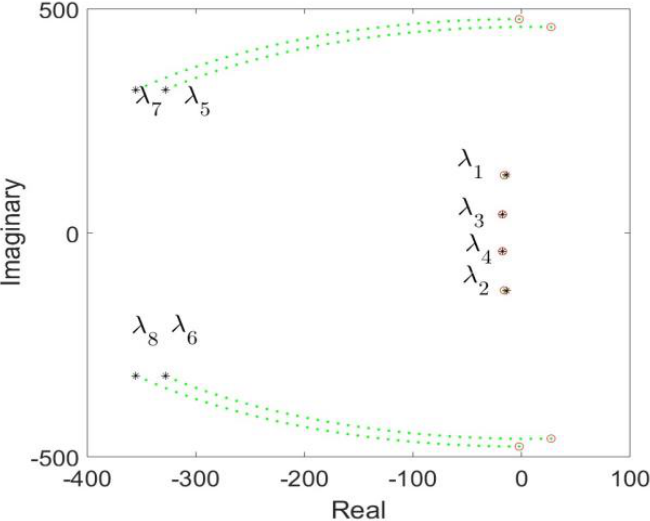
Figure 4. Eigenvalue loci of closed loop system with k p 1 from 1 to 0.1.